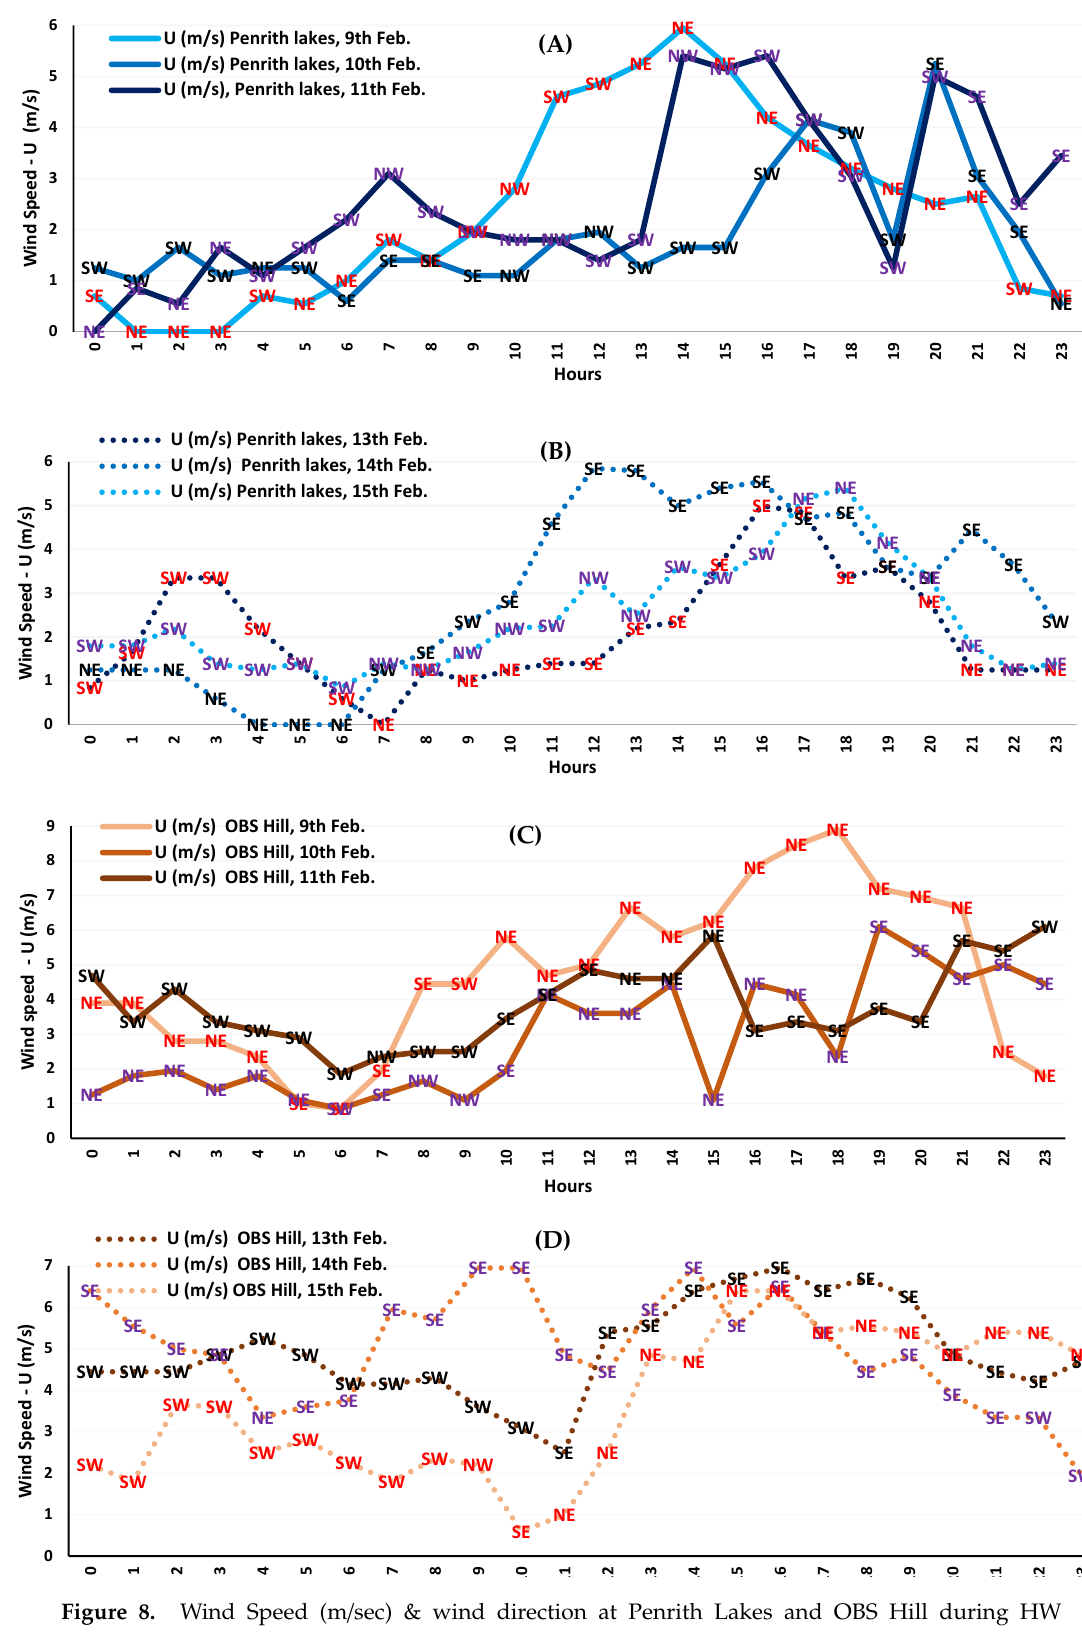
Figure 8. Wind Speed (m/sec) & wind direction at Penrith Lakes and OBS Hill during HW (9–11 February 2017) and NHW (13–15 February 2017) periods. ( A ) Penrith Lakes during the HW period,